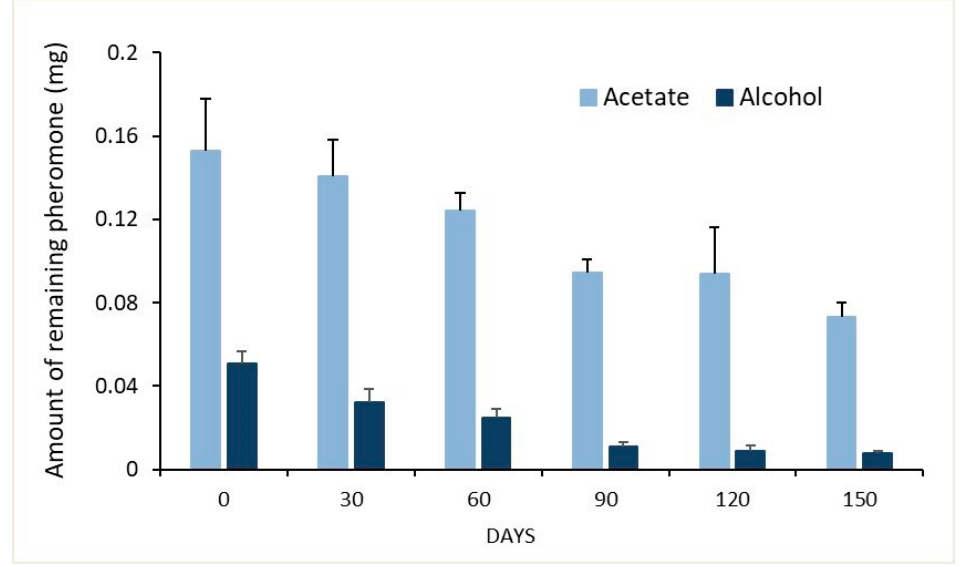
Figure 3. Amount of pheromone remaining ( µ g ± SE) in septa (original load of 200 µ g E11-14:OAc and 60 µ g E11-14:OH) aged up to 150 days under field conditions from October 2016 through March 2017.